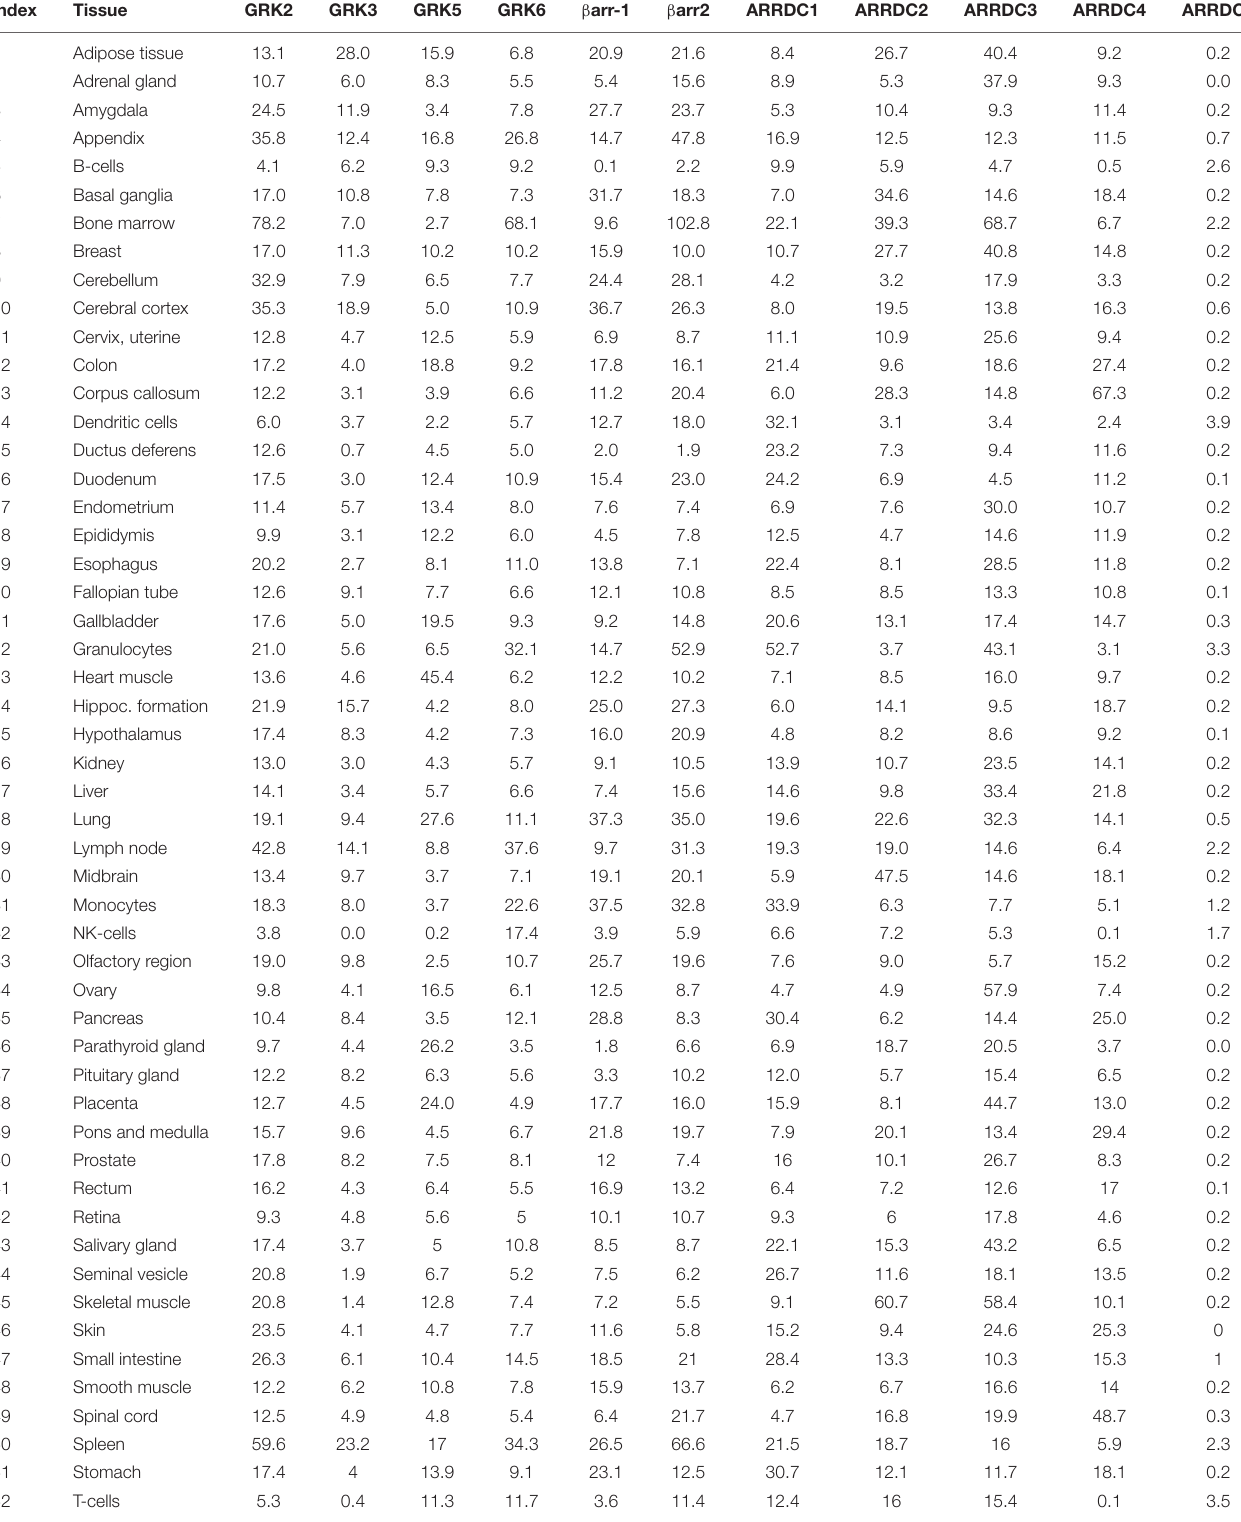
TABLE 1 | Relative tissue expression of GRK2, 3, 5, and 6, β -arrestin1 and -2, and